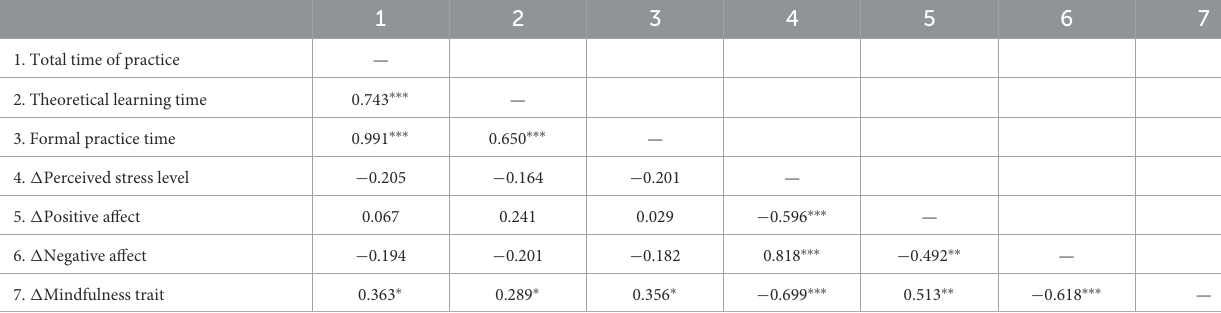
TABLE 6 Partial correlation between exercise time and change in psychological intervention effect